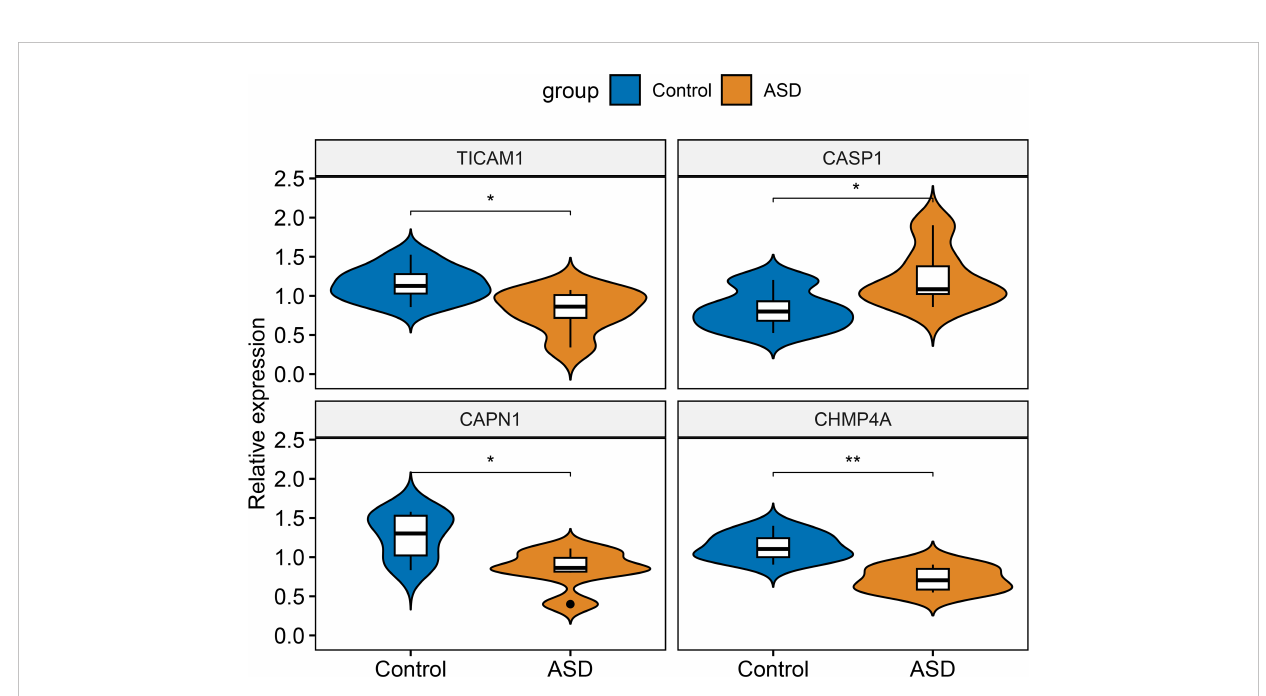
FIGURE 12 External validation of characteristic NRGs. Representative violin plots revealing the expressional differences in TICAM1, CASP1, CAPN1, and CHMP4A between control and ASD children. * p < 0.05, ** p <